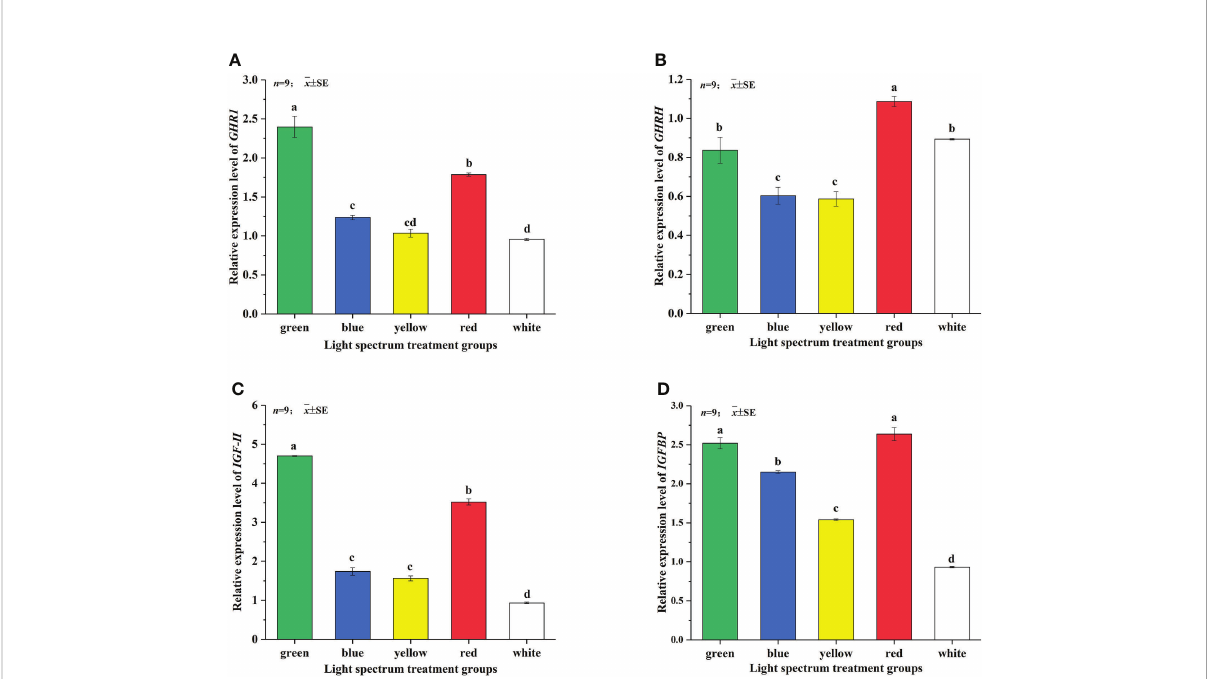
FIGURE 2 Effects of different LED spectra on relative expression of GHR1 (A) , IGF-I (B) , IGF-II (C) and IGFBP (D) genes in juvenile Takifugu rubripes . In the same column diagram, values with same small letter superscripts mean no signi fi cant differences ( P >0.05), different small letter superscripts mean signi fi cant differences ( P